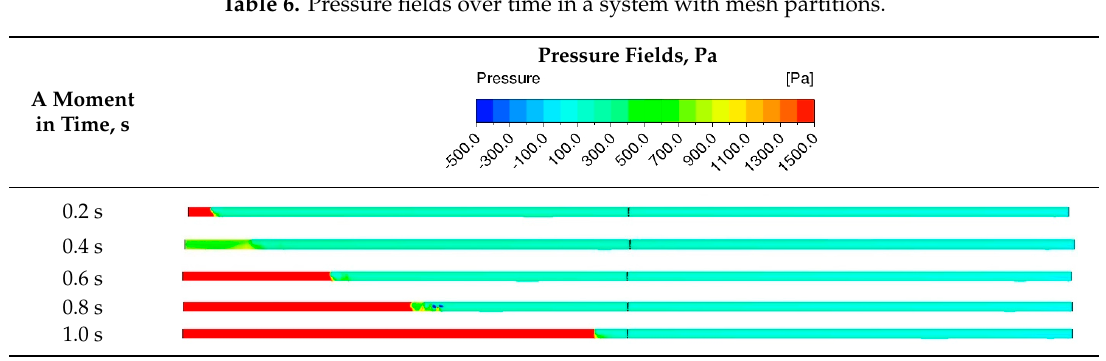
Table 7. Phase velocity fields in successive time moments in a system with mesh partitions.